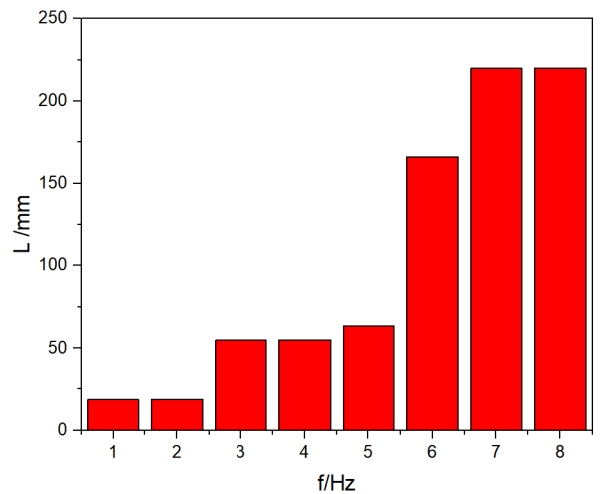
Figure 22. Frequency of L which value is 250 mm.